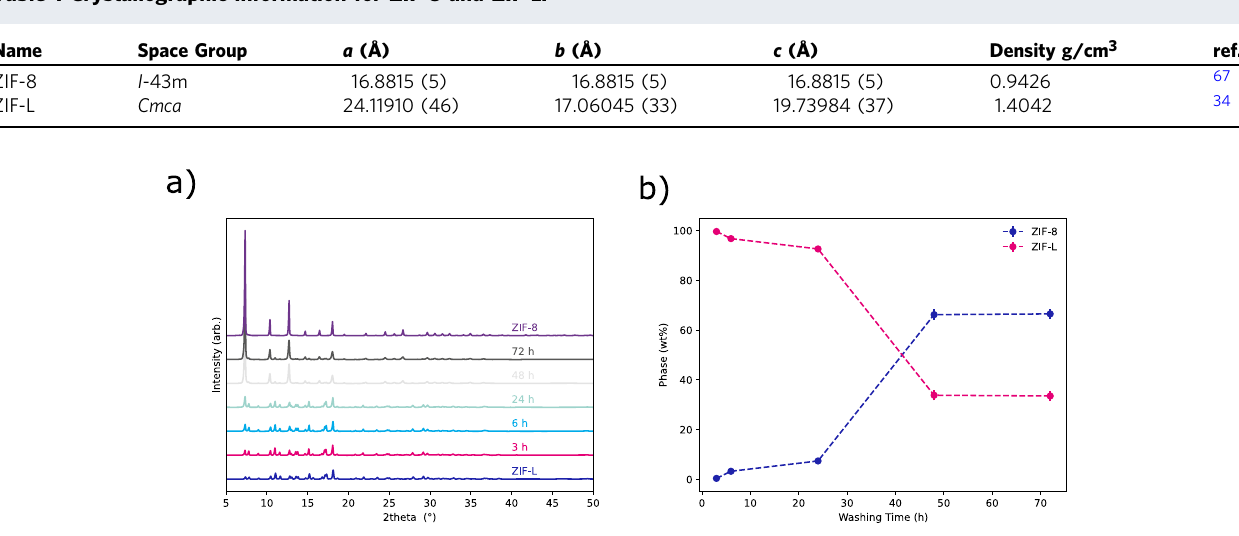
Fig. 2 Diffraction data showing the phase change. a PXRD patterns of as made ZIF-L and samples washed at 3 – 72 h, respectively. Also included is a reference pattern of ZIF-8 made by literature routes. b Phase percentages calculated from Rietveld re fi nements of ZIF-8 and ZIF-L for samples